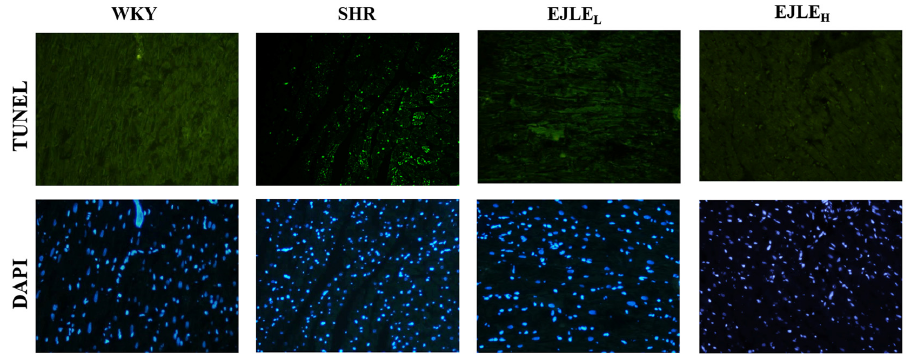
Figure 2. Effect of EJLE on cardiac apoptosis in SHR animals. Representative photomicrographs of TUNEL and DAPI stained nuclei in heart tissue sections of normotensive (WKY), spontaneously hypertensive rats (SHRs) and SHRs supplemented with low dose (EJLE L ) and high dose (EJLE H ) of EJLE. The images were acquired at 400× magnification.